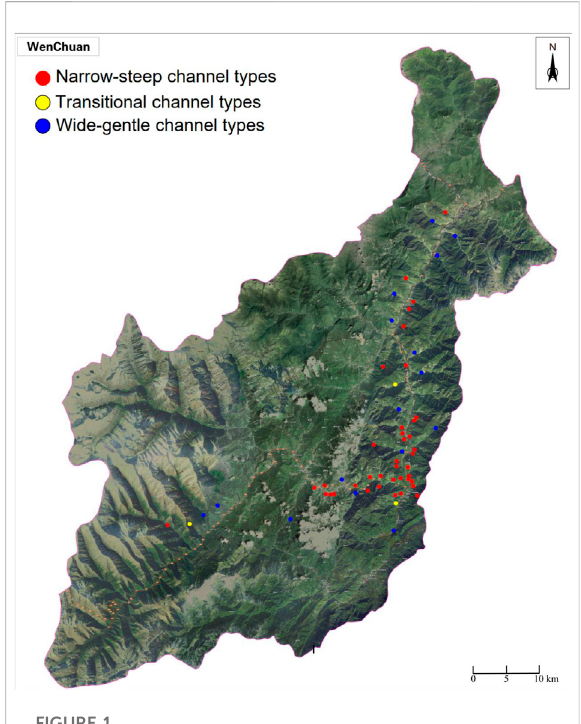
FIGURE 1 Distribution of the 58 debris fl ow gullies in